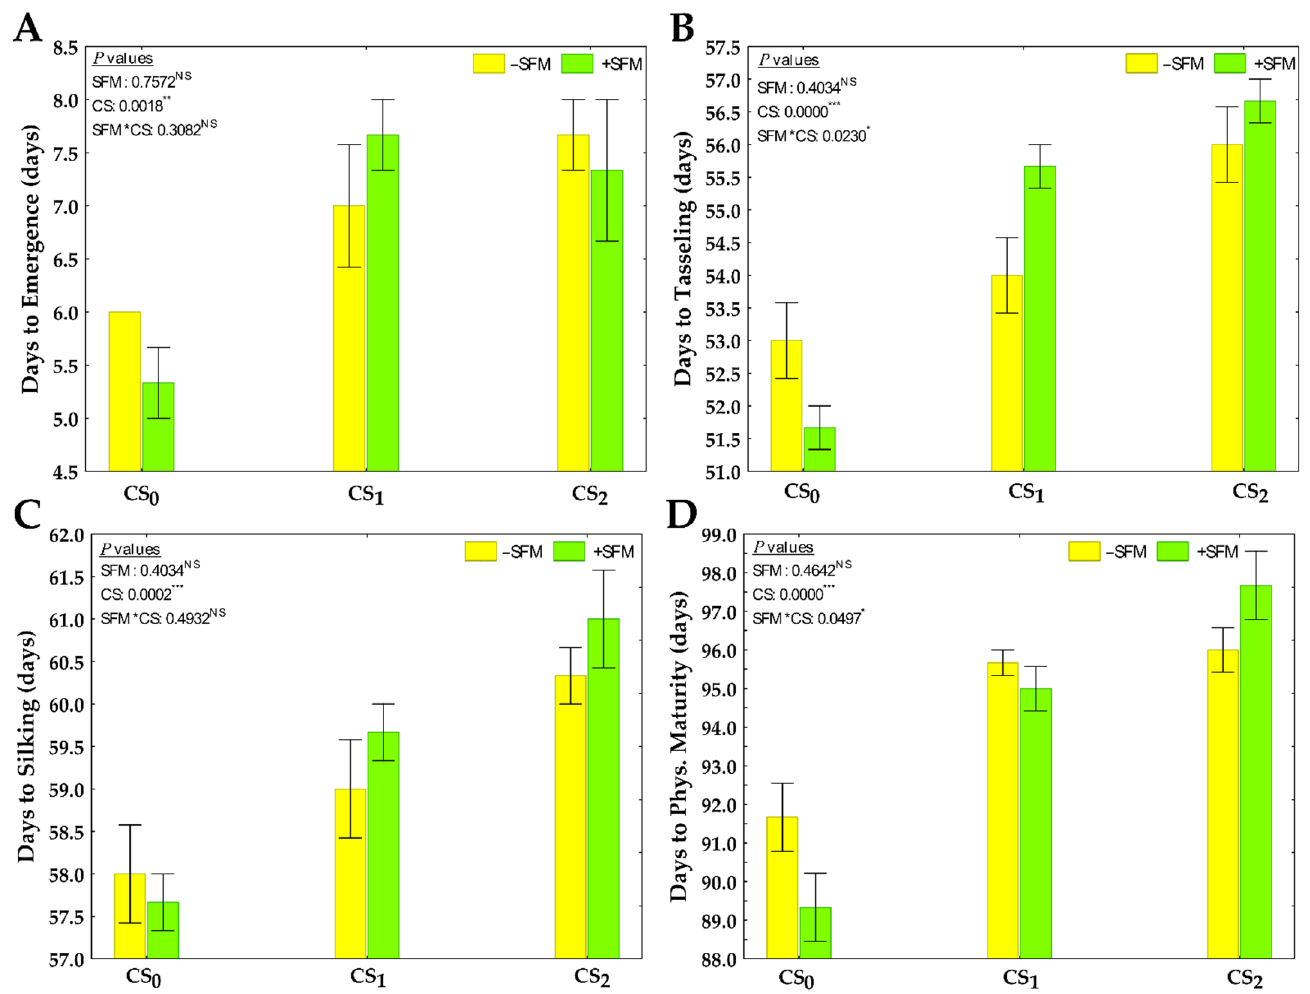
Figure 2. Length (days) of the main growth stages of sweet maize as affected by compost source, and sugarcane filter mud application. Days to emergence ( A ), days to tasseling ( B ), days to silking ( C ), and days to physiological maturity ( D ). CS 0 = control treatment with no CS input; CS 1 = crop residues (brassica residue); CS 2 = domestic wastes (household waste); − SFM = sugarcane filter mud not applied; +SFM = sugarcane filter mud applied. Bars represent ± SE ( n = 3). * 0.01 < p ≤ 0.05, ** 0.001 < p ≤ 0.01, *** p ≤ 0.001; NS: not